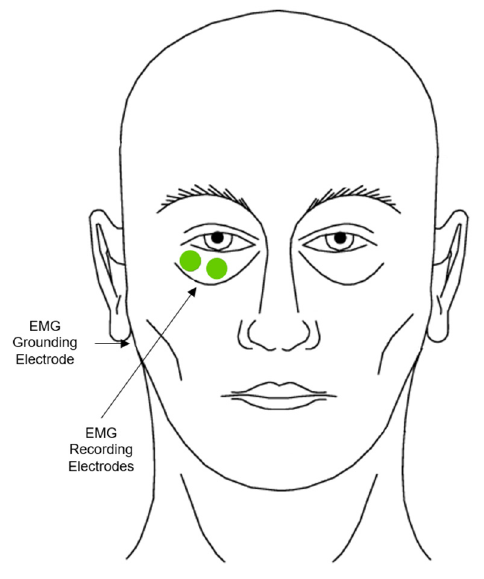
Figure 2. Placement of electrodes on the orbicularis oculi (adapted from: Blumenthal et al. [17])